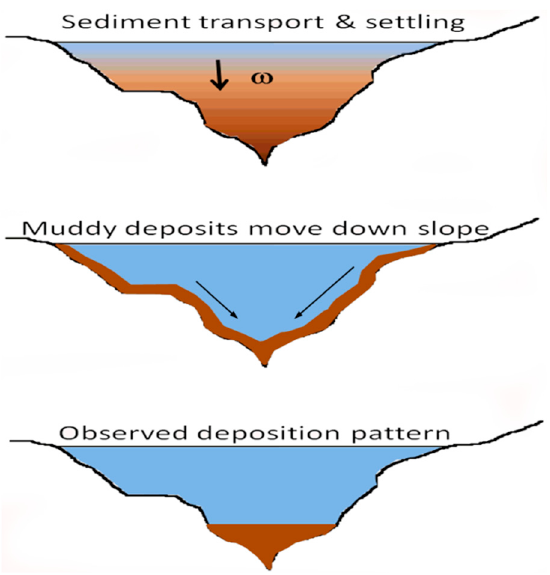
Figure 4. Schematic processes of fine ‐ grained particle sedimentation in the dam area [20].